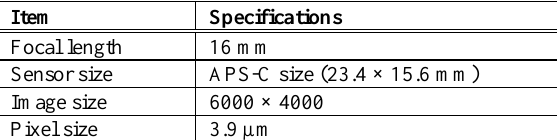
Table 3. Digital camera specifications